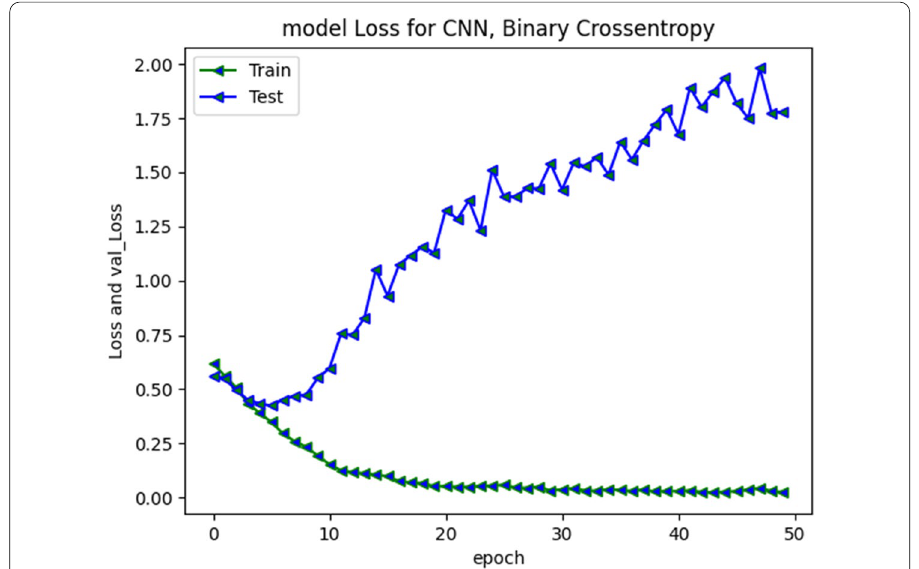
Fig. 18 CNN Model loss plot- Binary Cross entropy for 50 epochs